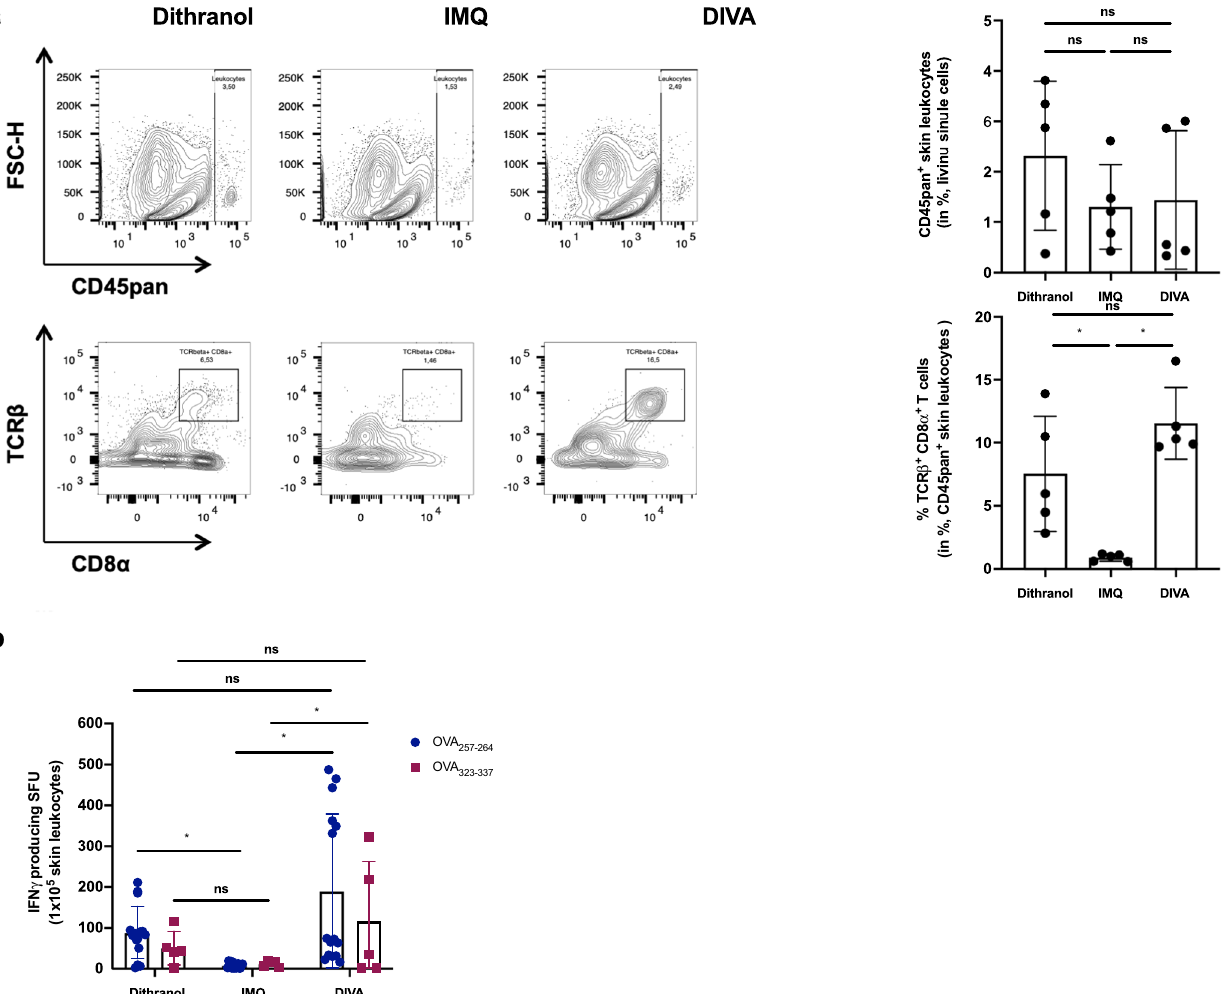
Fig. 3 Dithranol induces localized CD8 + and CD4 + T cell memory responses in the skin. C57B6/J wildtype mice were immunized as depicted in Fig. 2a. a Representative fl ow cytometry plots and quanti fi cation of dithranol, IMQ-TCI or DI-TCI treated murine ears following digestion with collagenase type IV & quanti fi cation of CD45 + leukocytes and TCR + CD8 + T cells on day 36 following TCI are depicted. b Ex vivo IFN- γ ELISpot assays of 2 × 10 5 murine ear skin-resident leukocytes following restimulation with either OVA 257 – 264 or OVA 323 – 337 peptide and OVA 257 – 264 -speci fi c CD8 + T cells by tetramer staining on day 36. Bars represent mean and SD of data collected from at least two independent experiments. *Signi fi cant difference with p < 0.05 by one-way ANOVA with Bonferroni ’ s post hoc test. Gating strategy in Supplementary Fig.